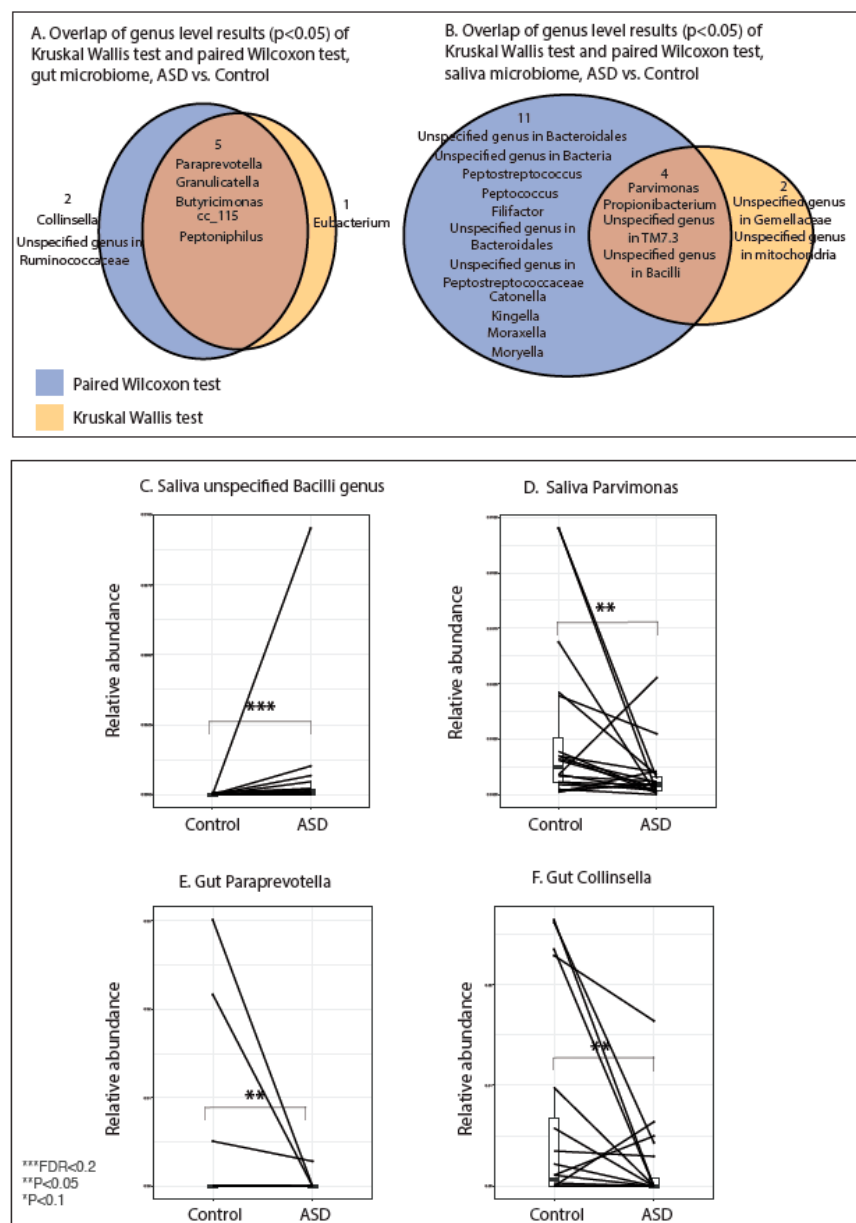
Figure 4. ( A , B ) Overlap of differentially abundant gut or salivary genera based on Kruskal–Wallis test and paired Wilcoxon test. Results are for taxa with unadjusted p < 0.05. ( C , D ) Paired-test representation of the relative abundances of top most differentially abundant salivary bacterial genera between ASD patient–family member control pairs. ( E , F ) Paired-test representation of the relative abundances of top most differentially abundant gut bacterial genera between ASD patient–family member control pairs. Single asterisk indicates p < 0.1 with adjusted FDR > 0.2; double asterisk indicates p < 0.05 with adjusted FDR > 0.2, triple asterisk indicates p < 0.05 and adjusted FDR < 0.2, Wilcoxon’s paired test.